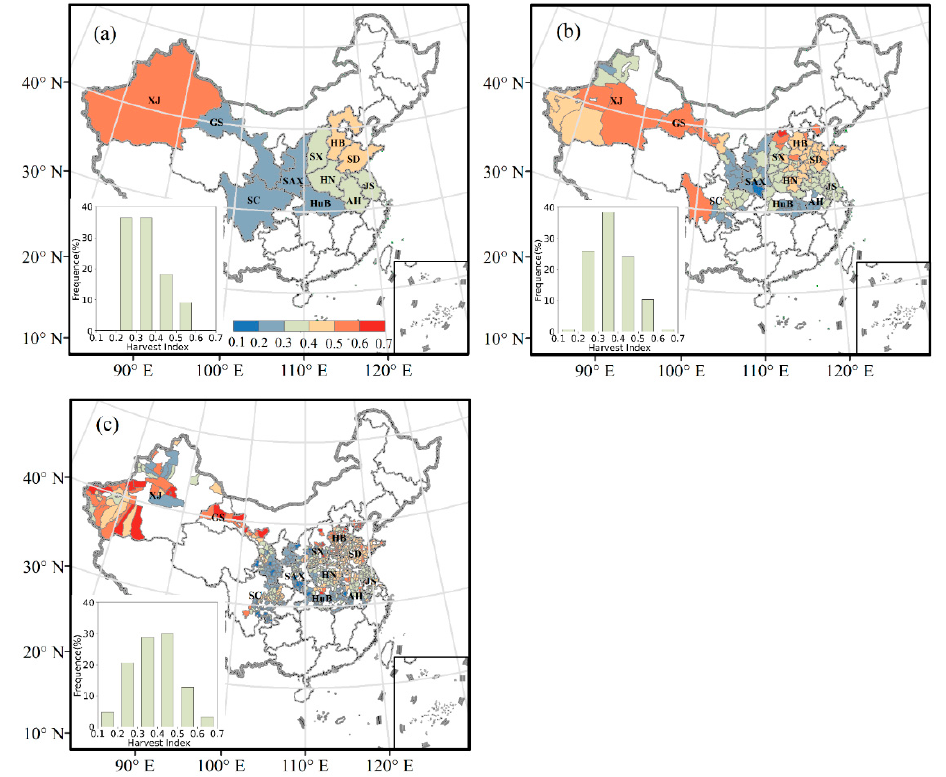
Figure 9. Spatial and frequency distributions of mean winter wheat harvest index at ( a ) province ( b ) municipal and ( c ) county scales. The inserts show the frequency distribution of harvest index.